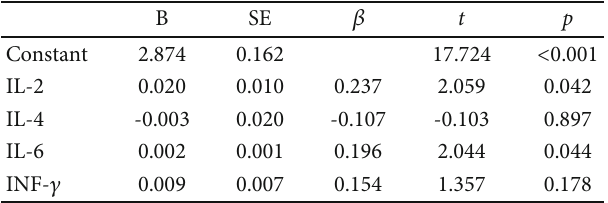
Table 3: Multiple linear regression analysis of DAS28 score and cytokines in patients with